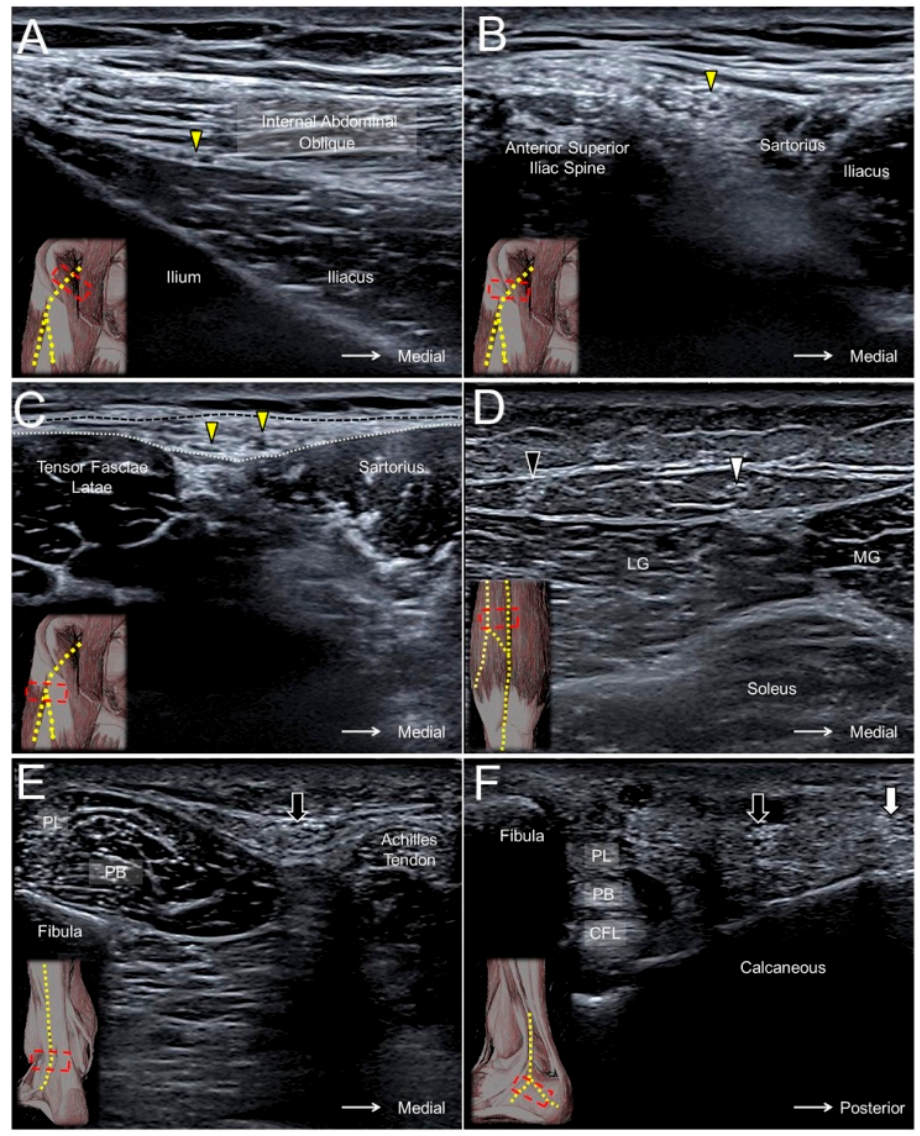
Figure 11. The lateral femoral cutaneous nerve (yellow arrowhead) at the level of the anterior iliac fossa ( A ), anterior superior iliac spine ( B ), and the fat compartment interposed between the sartorius and tensor fasciae latae muscles ( C ). The medial sural cutaneous nerve (white arrowhead) ( D ) and the lateral sural cutaneous nerve (black arrowhead) of the posterior leg, the sural nerve (black arrow) at the level of the distal leg ( E ), and the lateral foot ( F ). Black dashed line, fascia lata; white dashed line, fascia iliaca; MG, medial gastrocnemius; LG, lateral gastrocnemius; PL, peroneus longus; PB, peroneus brevis; CFL, calcaneofibular ligament; white arrow, lateral calcaneal branch of the sural nerve.